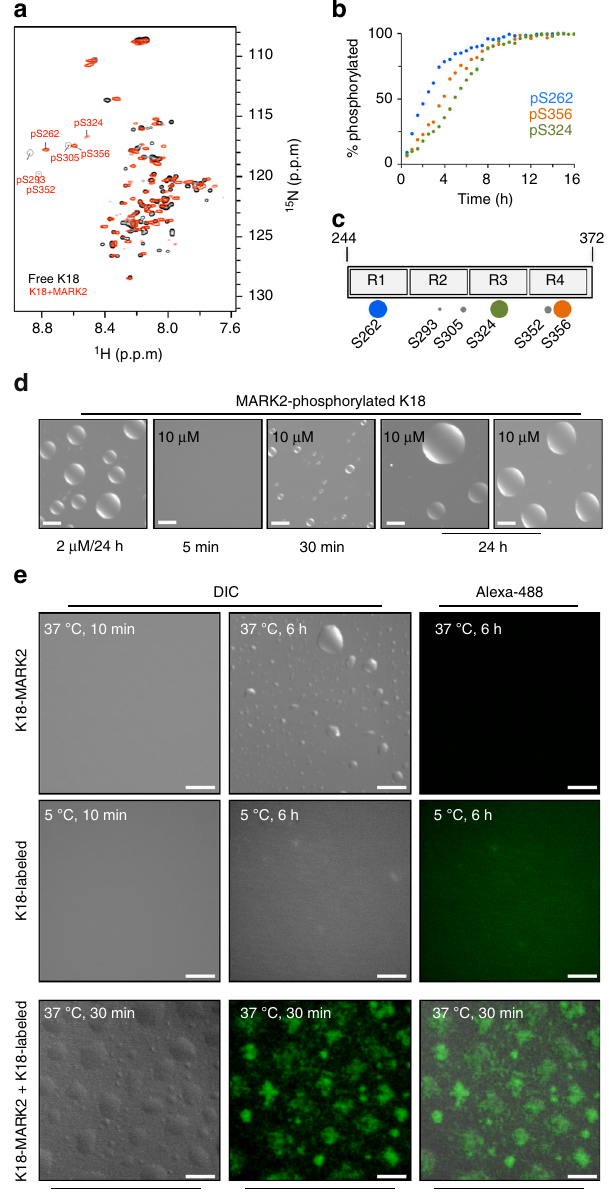
24 Fig. 8 MARK2-phosphorylation lowers the critical concentration of K18 LLPS. a 2D 1 H- 15 N HSQC spectrum of K18 (100 μ M protein in 50 mM sodium phosphate, pH 6.8) prior to ( black ) and after ( red ) phosphorylation by MARK2. NMR experiments were recorded at 5 °C. Cross-peaks of phosphorylated serine residues are labeled. b Residue-speci fi c kinetics of phosphorylation of K18 by MARK2. Errors in “ % phosphorylated ” were calculated on the basis of the signal-to-noise ratio in the spectra and were below 3%. Because S293, S305, and S352 were only phosphorylated by about 10 – 20%, reliable analysis of their phosphorylation kinetics was not possible. For details on in vitro phosphorylation of K18, please see the experimental section. c Schematic representation of the serine residues of K18 that were phosphorylated in vitro by MARK2. S262, S324, and S356 were 100% phosphorylated ( large dots ), in agreement with previous results 79 . d MARK2-phosphorylated K18 (50 mM sodium phosphate, pH 8.8, 0.5 mM TCEP) undergoes LLPS when incubated at a concentration of 2 μ M at 37 °C ( left panel ), i.e., the concentration at which Tau is estimated